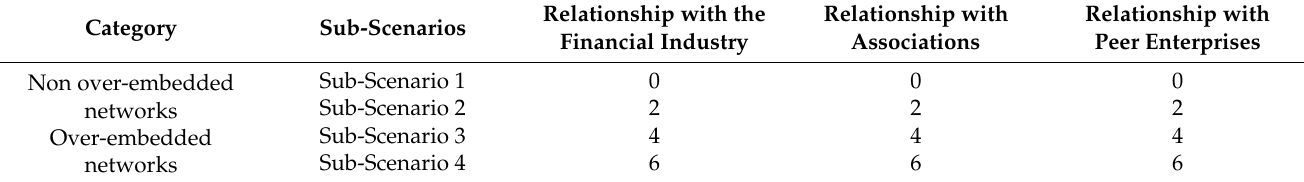
Table 6. Enterprise network relationship scenario setting.